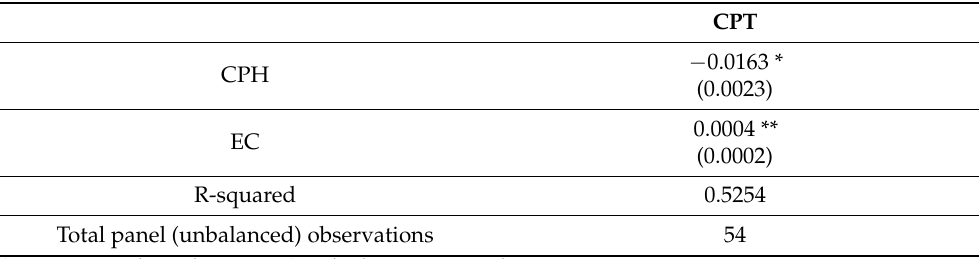
Table 6. Empirical results on a subsample formed by below average share of the time for a customer payment.